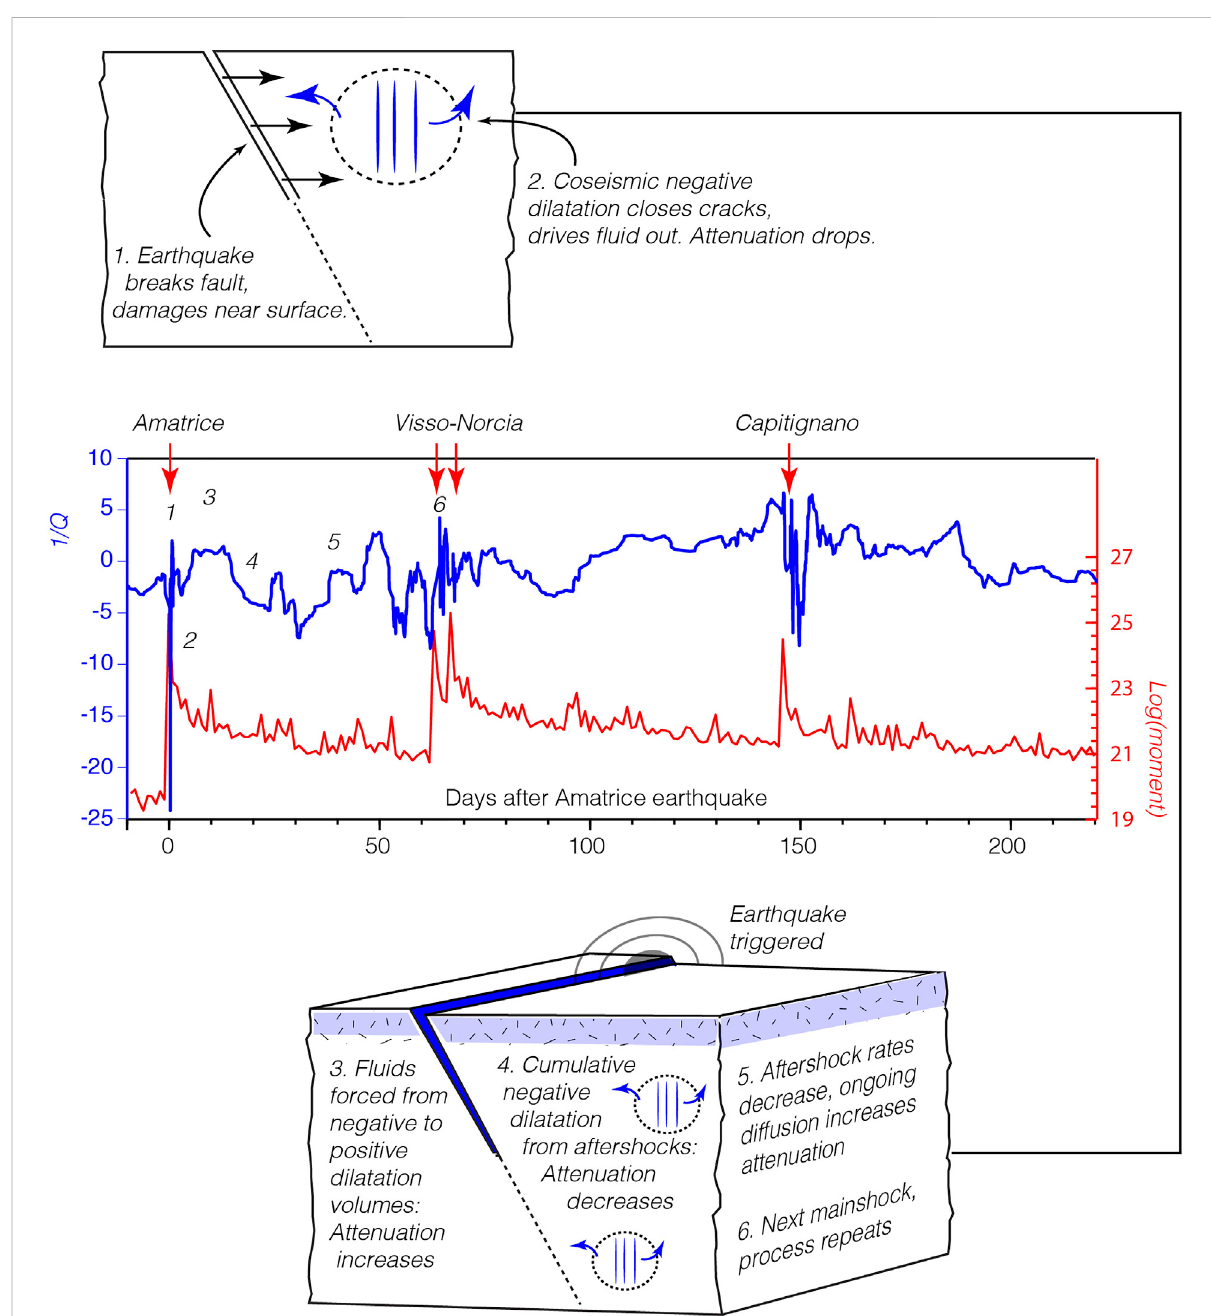
FIGURE 14 Conceptual model of fl uid behavior. Scaling the attenuation vs. time curves from after the Amatrice, Norcia, and Capitignano earthquakes, we note a consistent shape. Each mainshock that initiates a sequence is associated with a sharp increase in Q − 1 S ( f , t ) , f (cid:2) 2 . 2 Hz , followed by a comparatively steep drop. This happens during periods where potential diffusion is also observed. A subsequent gradual recovery in Q − 1 ( f , t ) , f (cid:2) 2 . 2 Hz , persists up until the next mainshock. We hypothesize that this recovery is associated with the redistribution of fl uids into S newly damaged faults and into the shallow